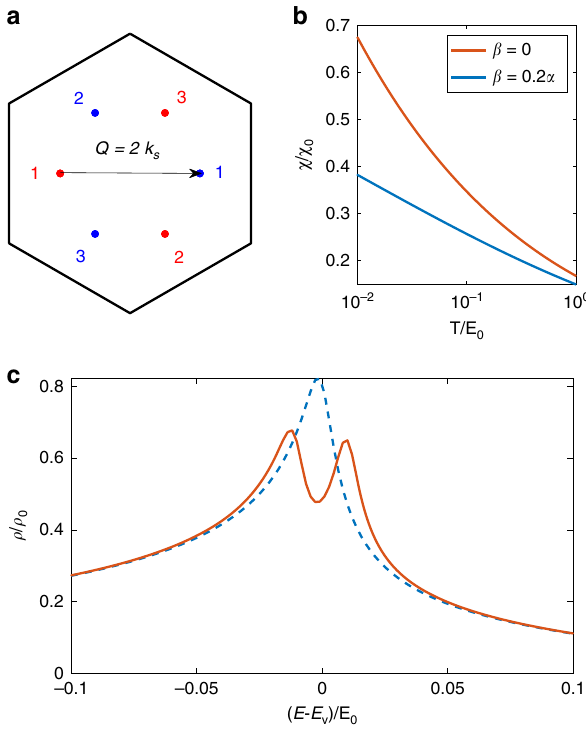
Fig. 4 Particle-hole nesting and density wave instability in twisted bilayer graphene. a Six high-order VHS in MBZ, where different colors denote different valleys, and 1, 2, 3 denote three Γ M directions. b Temperature dependence of intervalley susceptibility χ (cid:5) χ ð Q ; E v Þ at ordinary ( β ¼ 0 : 2 α ) ¼ α (cid:4) 1 . c Density of states and high-order ( β ¼ 0) VHS with Q ¼ 2 k s and χ 0 with (solid) and without (dashed) intervalley density wave. Here E 0 ¼ α 3 = ~ γ 2 and details can be found in the Methods